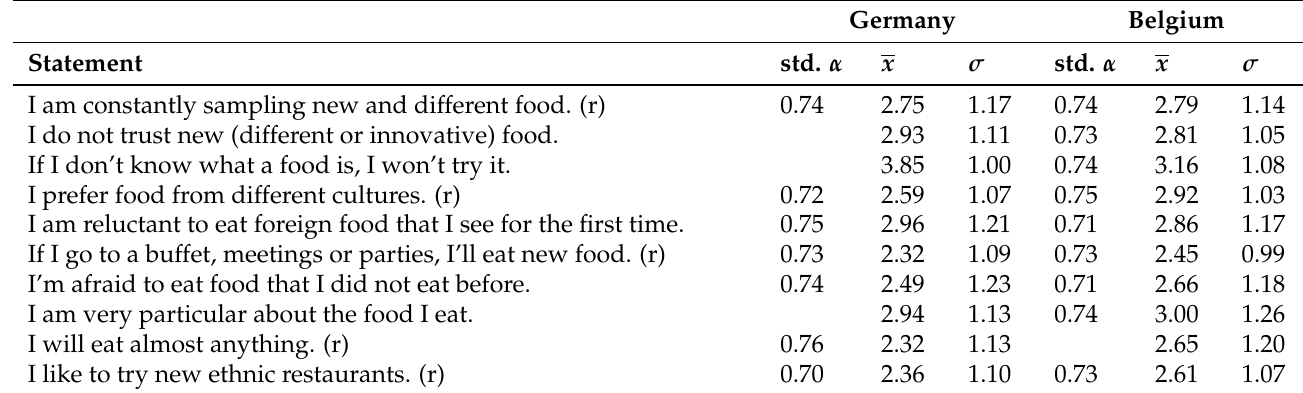
Table 6. Food Neophobia Scale (FNS). (r), inversely